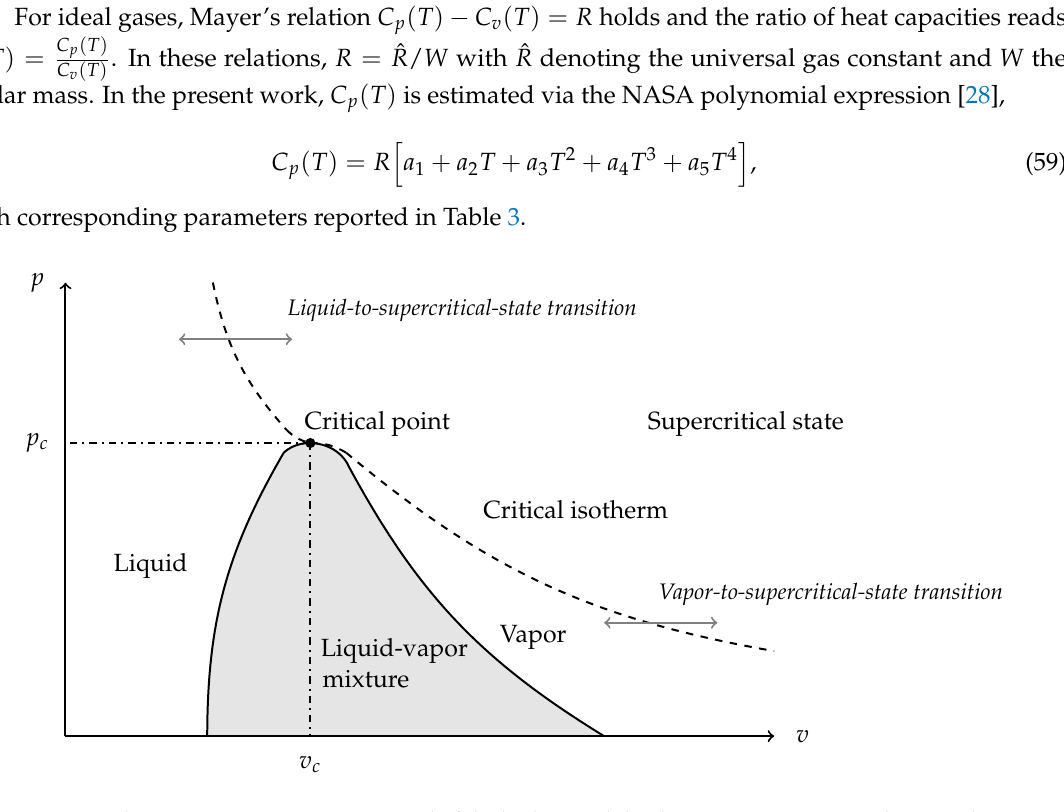
Figure 3. The saturation curve is composed of the boiling and the dew curves separating the two-phase mixture zone and the pure phase zones. Beyond the critical isotherm, there is no transition between the liquid and the gaseous state. The fluid is neither liquid nor gas. It is said to be supercritical. Phase transition can happen either through the saturation dome corresponding to liquid–vapor phase change, or through the critical isotherm corresponding to a pure-phase-to-supercritical-state transition. Table 3. Parameters of the NASA polynomial expression [28] for the heat capacity at constant pressure, Equation